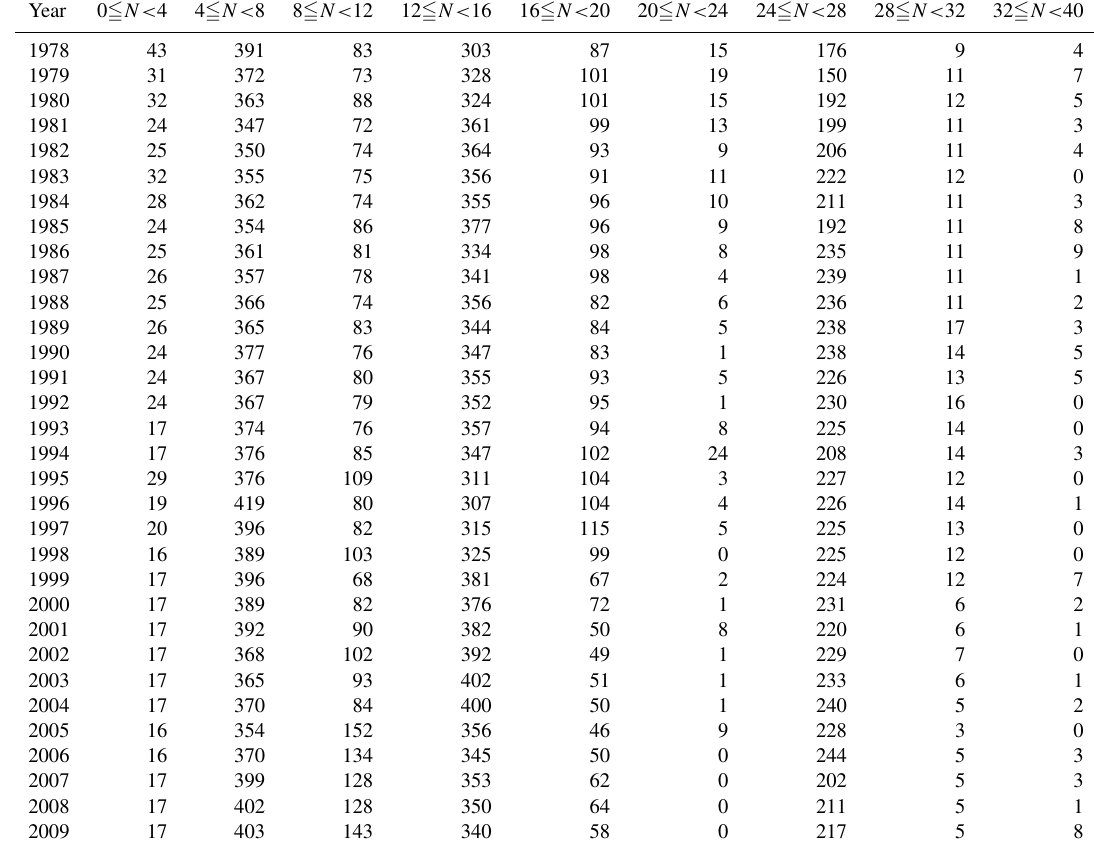
Table 1. Number of samples ( N ) collected at each of the 1481 monitoring sites each